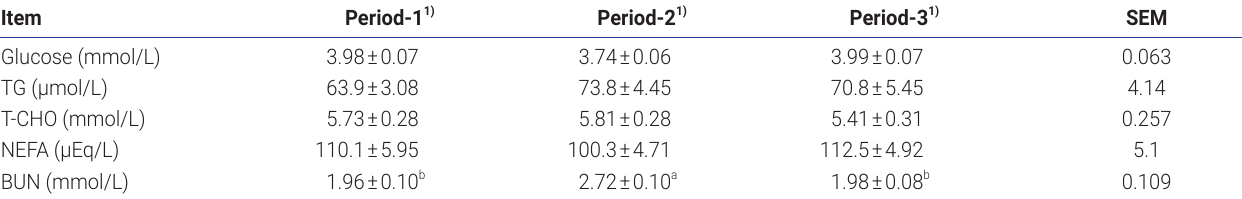
Table 4. Effects of feeding periods on plasma metabolite concentrations in dairy cows